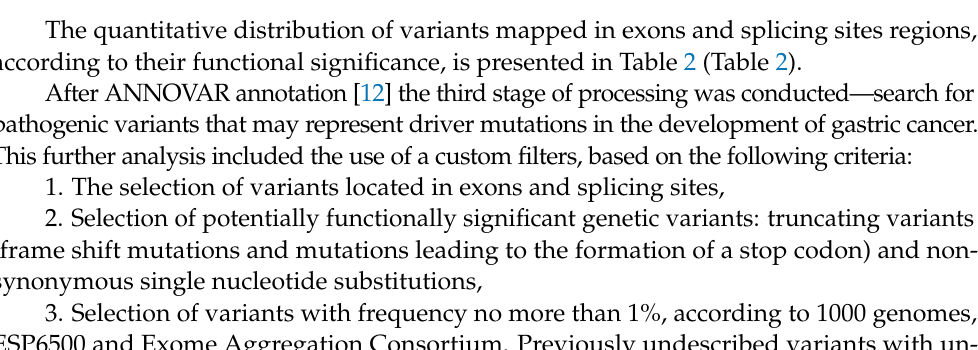
Figure 1. Distribution of variants mapped in exons and splicing sites regions, according to their functional significance ( a ) Tumor tissue; ( b ) Normal